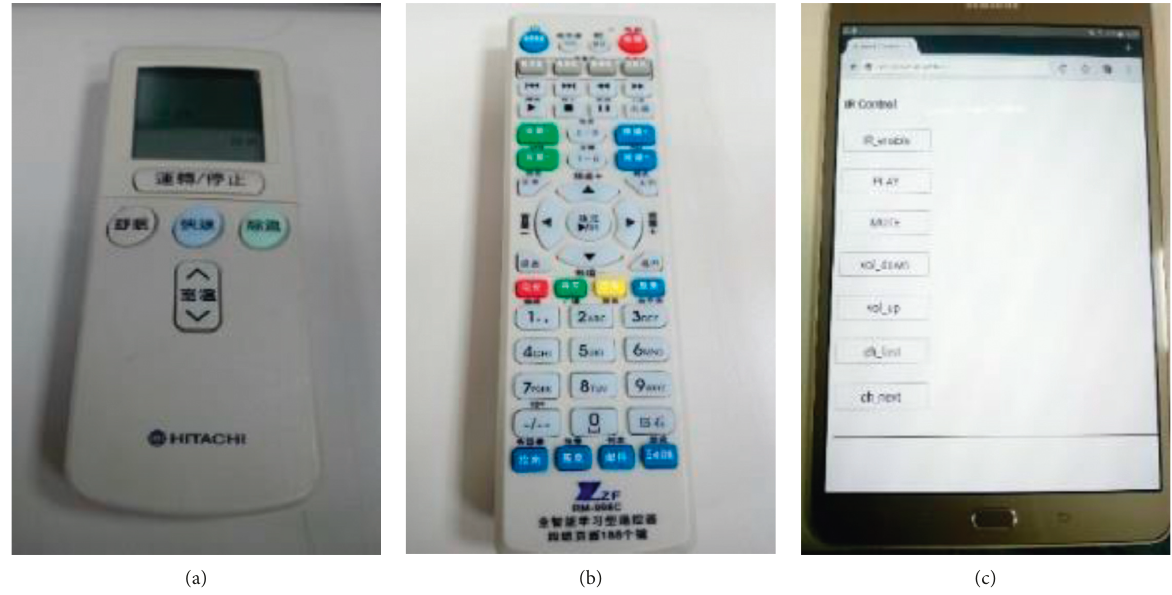
Figure 5: IR remote controllers of (a) HITACHI air conditioner, (b) recordable URC, and (c) our